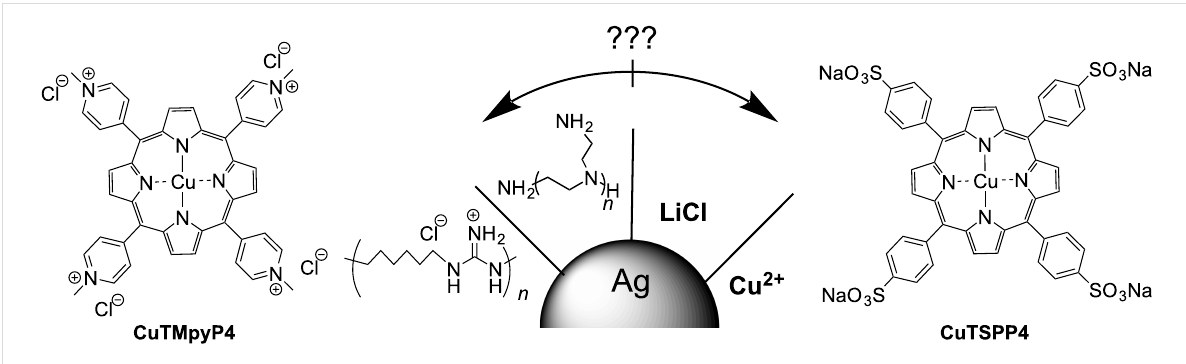
Figure 6: Schematic illustration of Ag surface modifications by PHMG, PEI, LiCl, and Cu 2+ , and charged model analytes CuTMpyP4 and CuTSPP4.